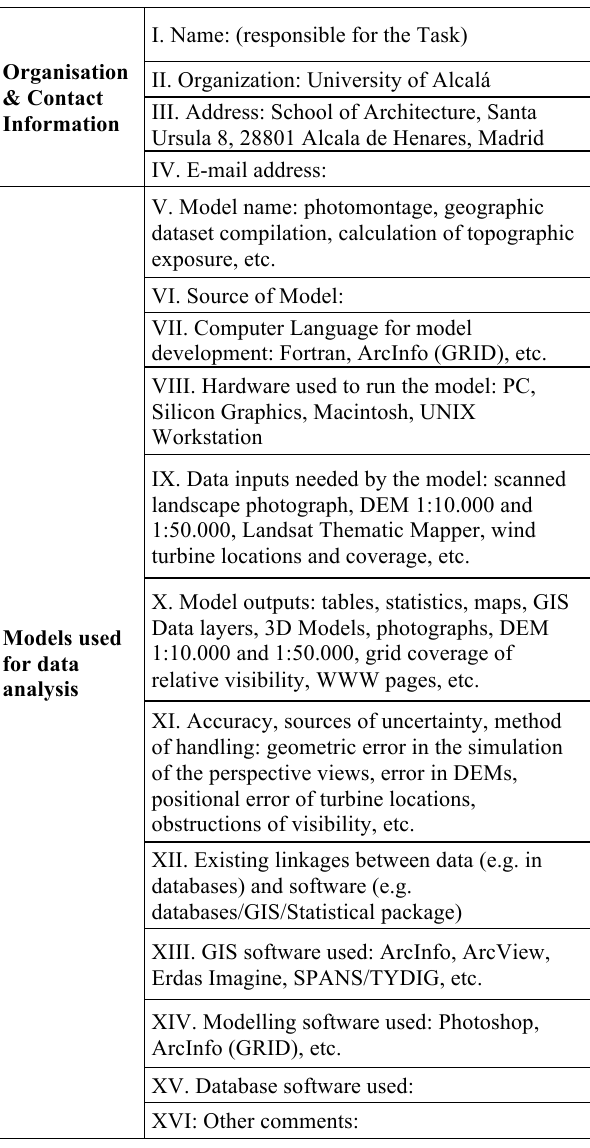
Table 1. Wind Farm at Sierra de Erreniega: Project Planning Information Document template (Adapted from Macaulay Land Use Research Institute